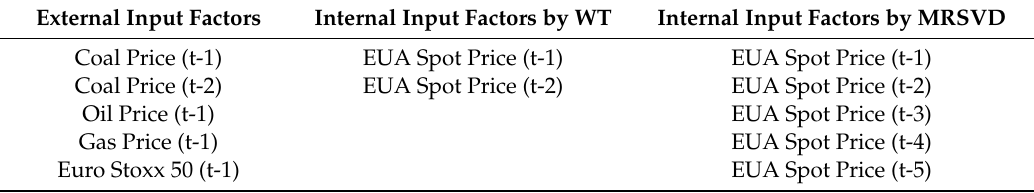
Table 4. The results of external and internal input factors selection for EUA spot price